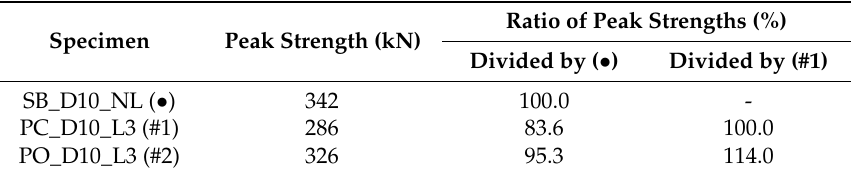
Table 5. Effect of steel pile cap strengthening methods for D10_L3 specimens.